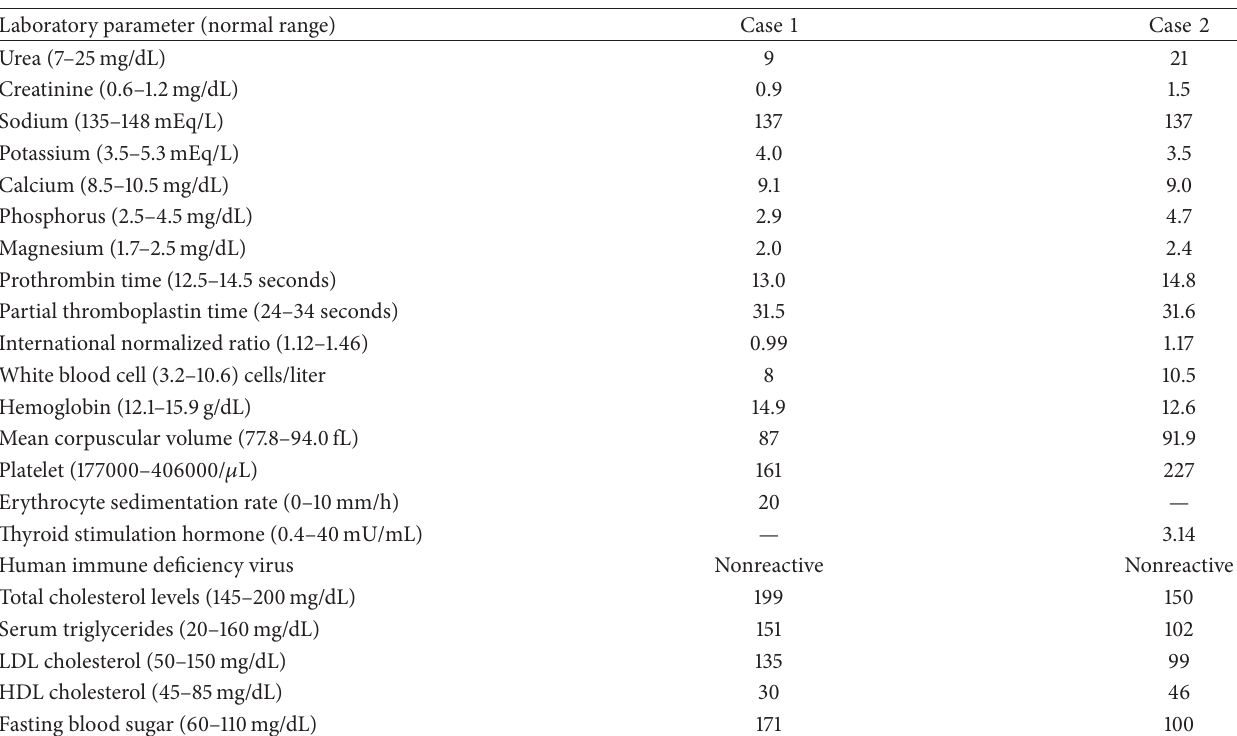
Table 2: Laboratory data of the patients at admission in the hospital and during